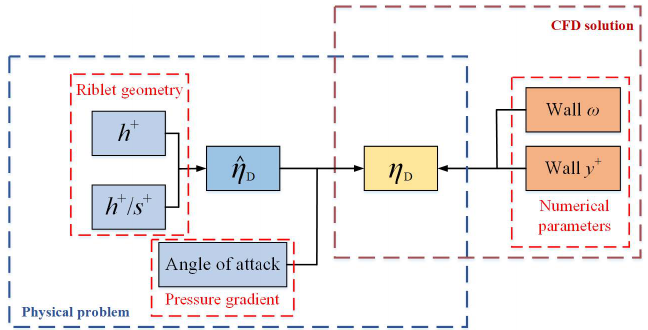
Figure 1. Schematic picture of the construction of the modified SST-RC